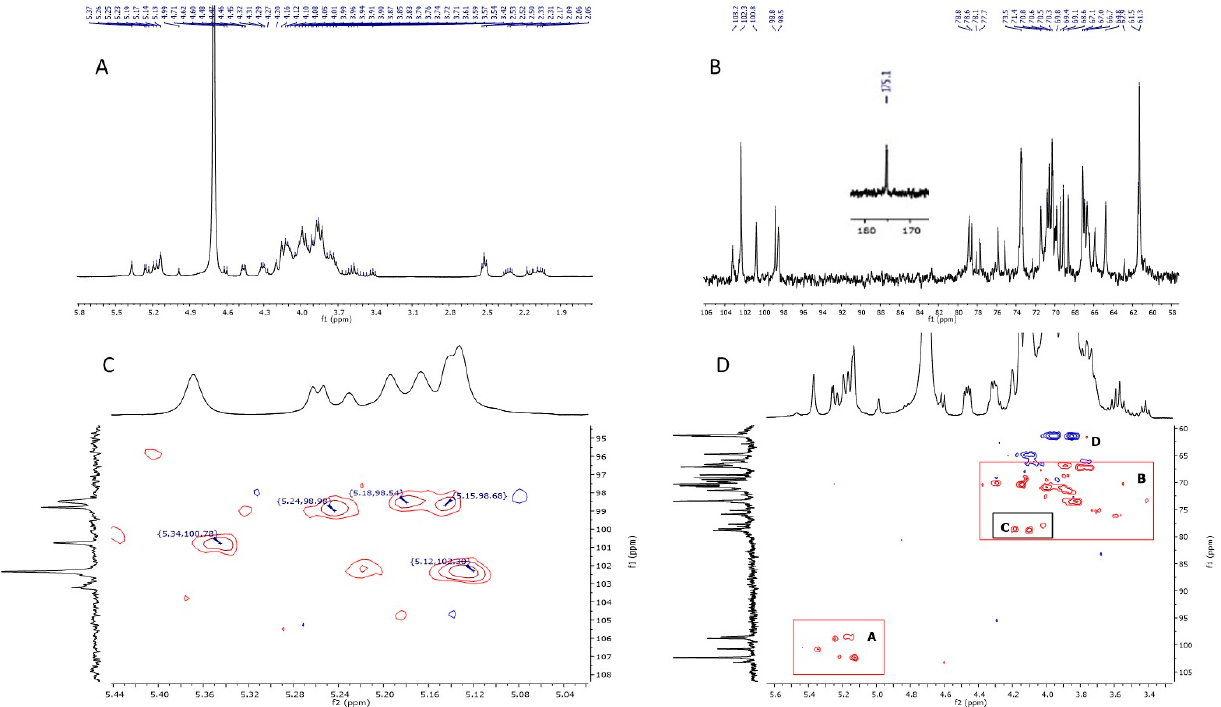
Figure 7. ( A ) 1H NMR spectra ( B ) 13C NMR spectrum (106-58 ppm amplified zone plus carbonyl signal) of EPS, ( C ) HSQC spectrum (anomeric zone) of EPS obtained at 60 °C in 2H 2 O, and ( D ) Edited gradient-enhanced HSQC spectrum of ESP, showing A: anomeric region, B: CH groups, C: CH position 2 (linkage position) on α -D-Manp and β -D-Manp, D: CH2 groups in position 6.